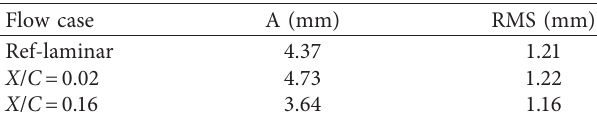
Table 3: RMS of average shock oscillations and shock amplitude for flow cases with the microstep.